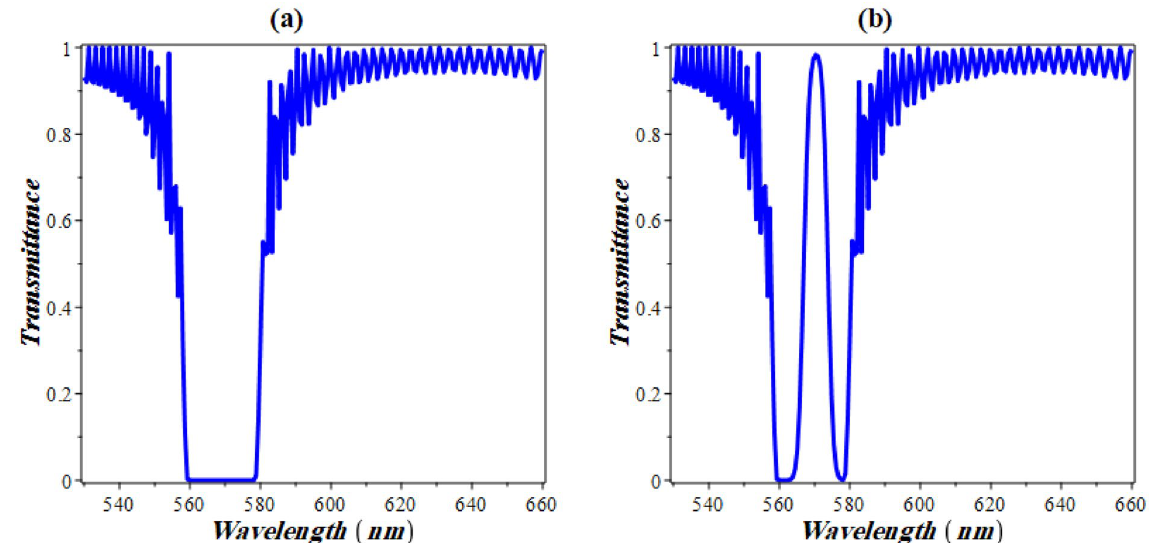
Figure 3. The transmittivity of the designed 1D PCs in which nonlinear stacks of GaP embedded in NaI solution with a concentration of 0.35 for: ( a ) the absence of Kerr nonlinearity and ( b ) the presence of defocusing nonlinearity.